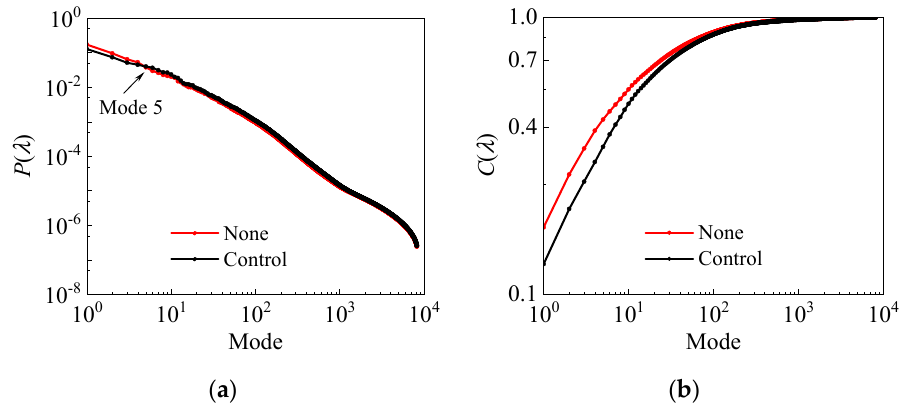
Figure 3. Flow field energy distributions: ( a ) Single energy; ( b ) Cumulative energy.